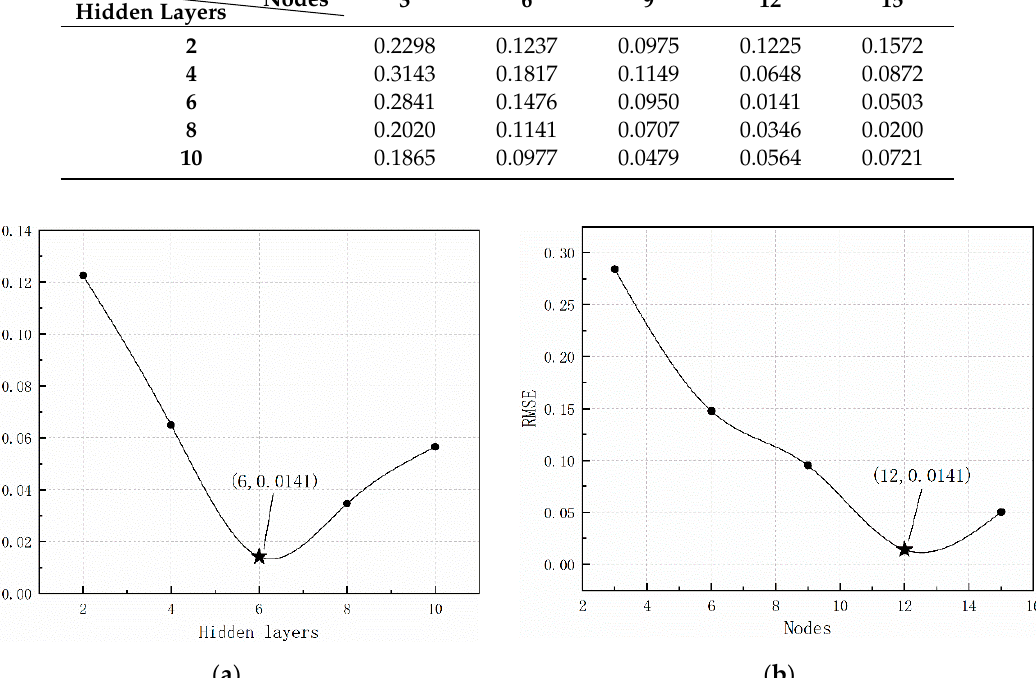
Figure 6. RMSE with different time steps. The model weight was initialized using the Xavier method. The dropout layer was added to prevent overfitting. The Adam adaptive learning rate algorithm was used to optimize the gradient descent process, and a session training model was constructed. The model was iterated 500 times, and Figure 7 presents the change in the loss values. The model converged after approximately 200 iterations.